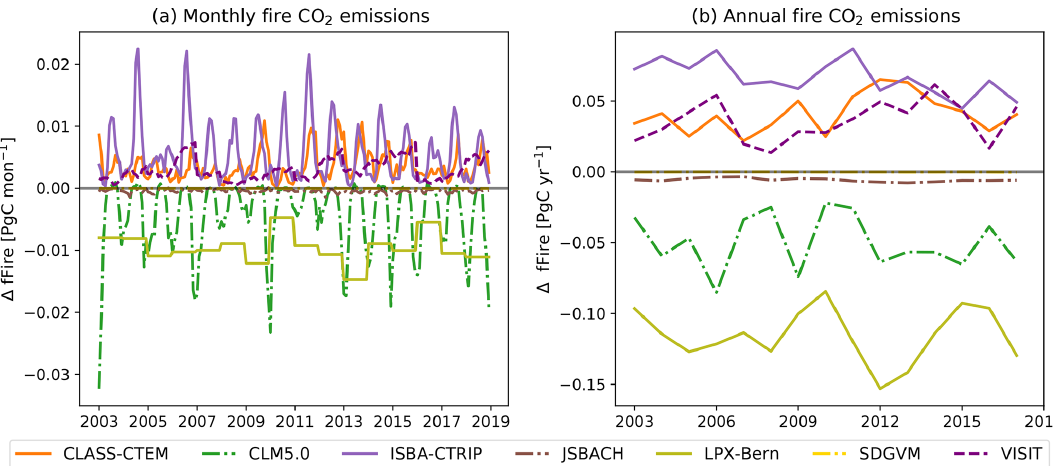
Figure C7. Difference between CO 2 + CLIM + LUC and CO 2 + CLIM simulations for monthly (a) and annual (b) fire CO 2 emissions of six TRENDY